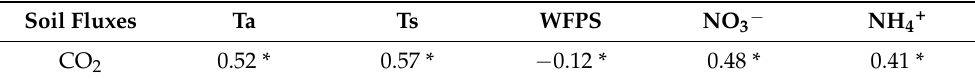
Table 4. Correlation coefficient between CO 2 -C fluxes from soil and atmospheric (Ta) and soil (Ts)